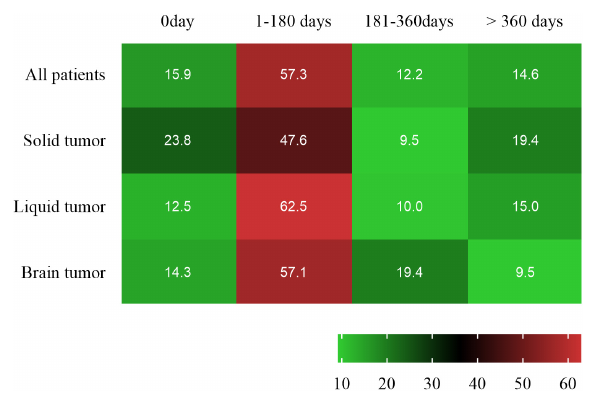
FIGURE 2 | Heat map of time interval between cancer diagnosis and SAH onset. TABLE 2 | Presentation and etiology of subarachnoid hemorrhage in patients with cancer a . Characteristic All patients, n = 82 n